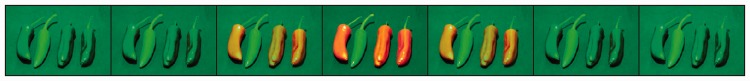
A sequence of frames taken from a video of the neon fruit illusion. Video available in the online supplement.